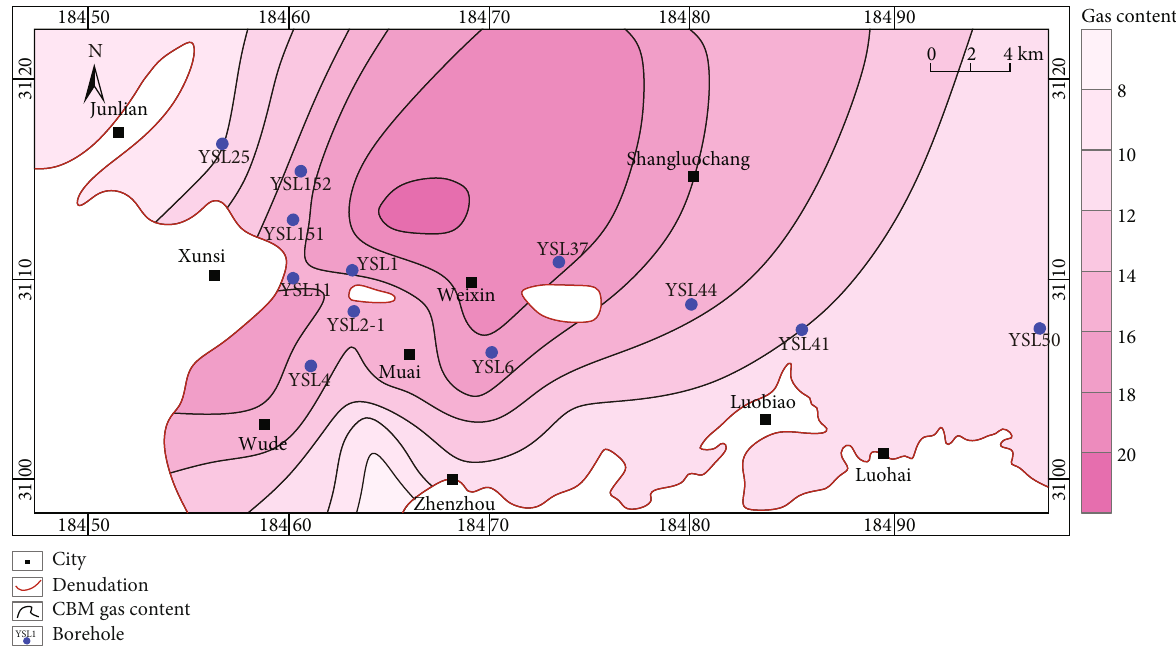
+ C 7 8 coal seam in the Junlian mine